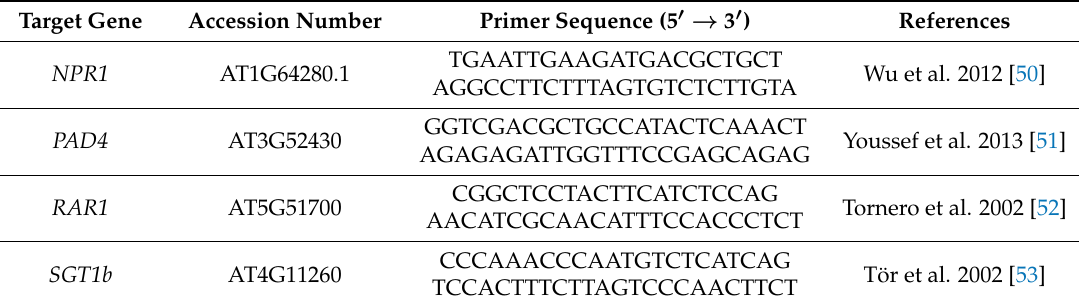
Table 3. Primers were used in the described gene expression of defense